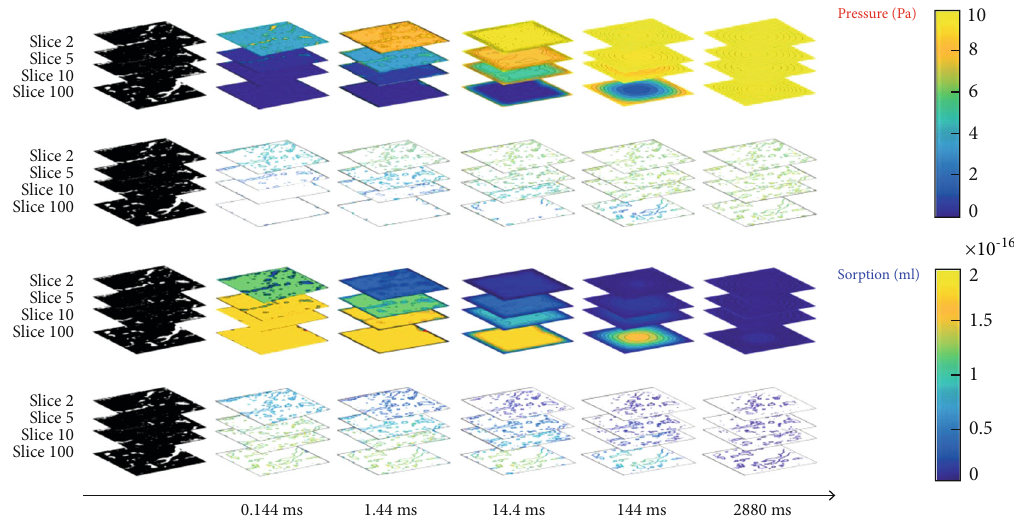
Figure 8: The gas pressure and adsorbed gas distribution during the process of adsorption and